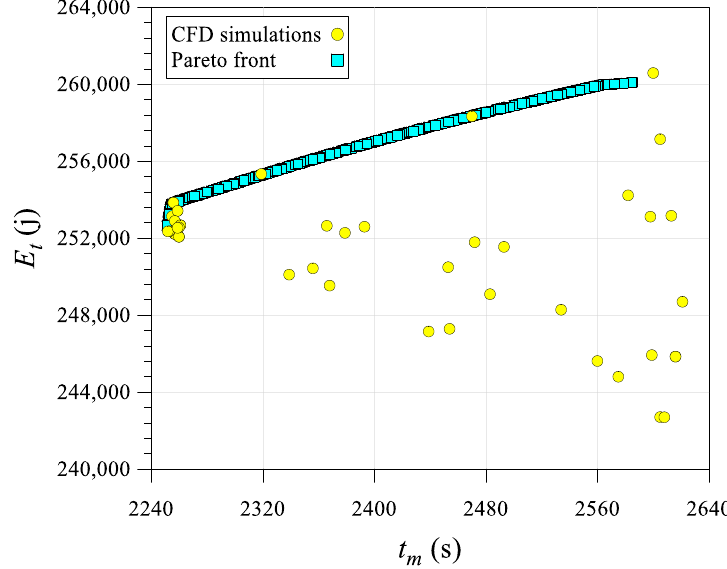
Figure 9. Overlap graph Pareto optimal points and CFD results.